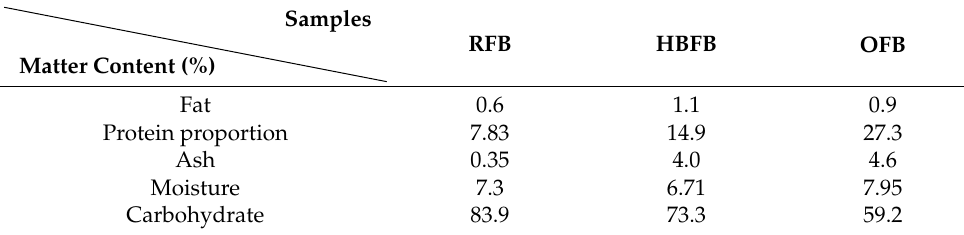
Table 6. The substance content of RFB, HBFB,